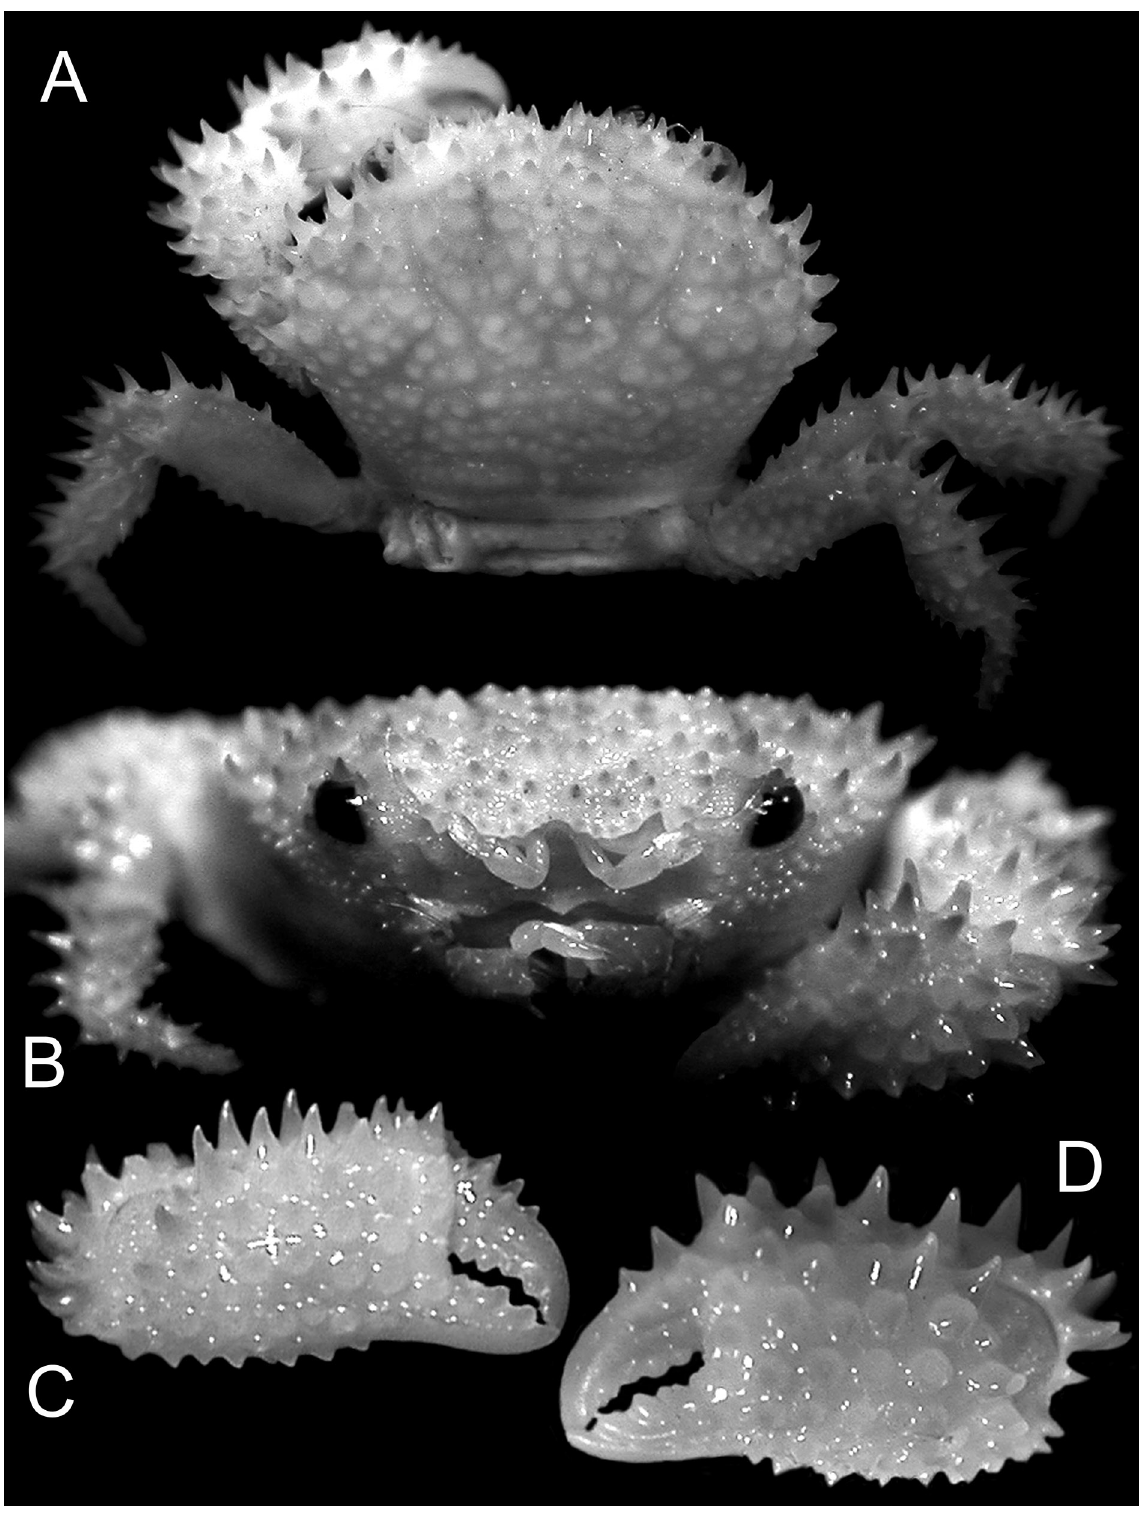
Fig. 2. Actaea grimaldii sp. nov., holotype, ♂, 6.2 × 4.4 mm (MNHN IU 2013-921), Papua New Guinea. A . Dorsal view of habitus. B . Frontal view of carapace. C . Outer view of right chela. D . Outer view of left